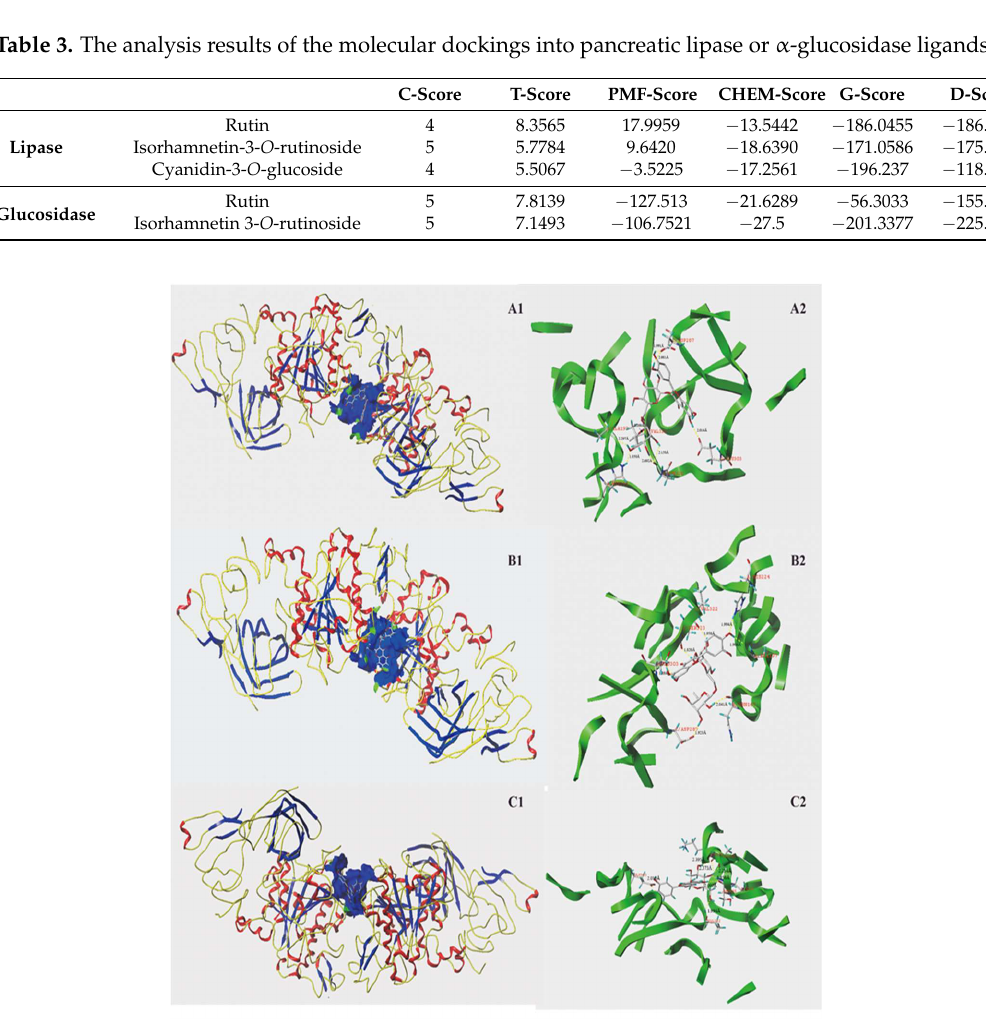
Figure 6. Molecular docking of three phenolic compounds with porcine pancreatic lipase. Three phenolic compounds were inserted into the hydrophobic cavity of porcine pancreatic lipase (blue) in the surface structure (( A1 ), rutin; ( B1 ), isorhamnetin-3- O -rutinoside; ( C1 ), cyanidin-3- O -glucoside). Interactions between three phenolic compounds and amino acid residues in the active site of porcine pancreatic lipase: rutin conformation ( A2 ), isorhamnetin 3- O -rutinoside conformation ( B2 ), and cyanidin-3- O -glucoside conformation ( C2 ), with residues in the active sites of the pancreatic lipase, respectively. The dashed line stands for hydrogen bonds.